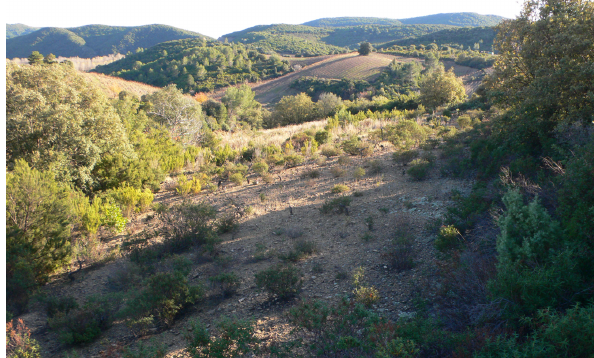
Figure 7. Abandoned vineyard field colonized by native Mediter- ranean plant species in the Languedoc region (France), with some vines still visible (Photograph by E.